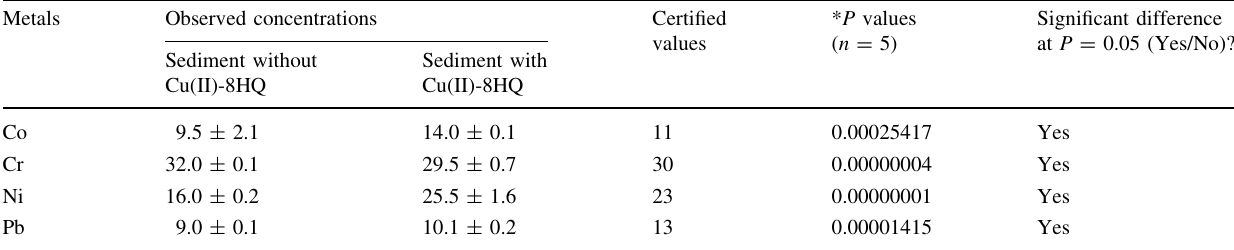
Table 2 Observed concentrations ( l g/mL) of metals in standard reference materials with certified values